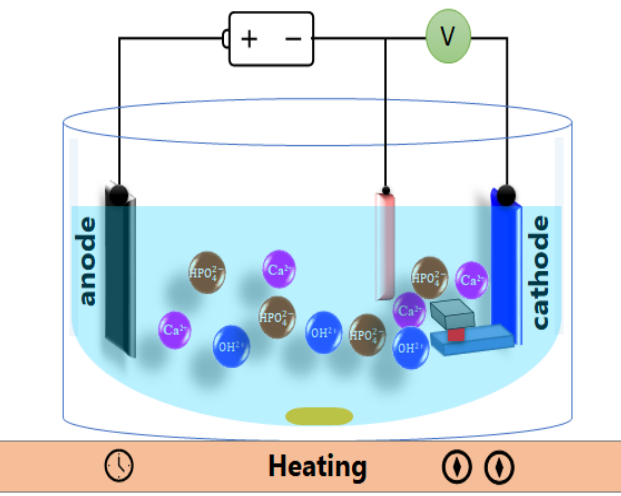
Figure 1. Schematic representation of electrodeposition process.